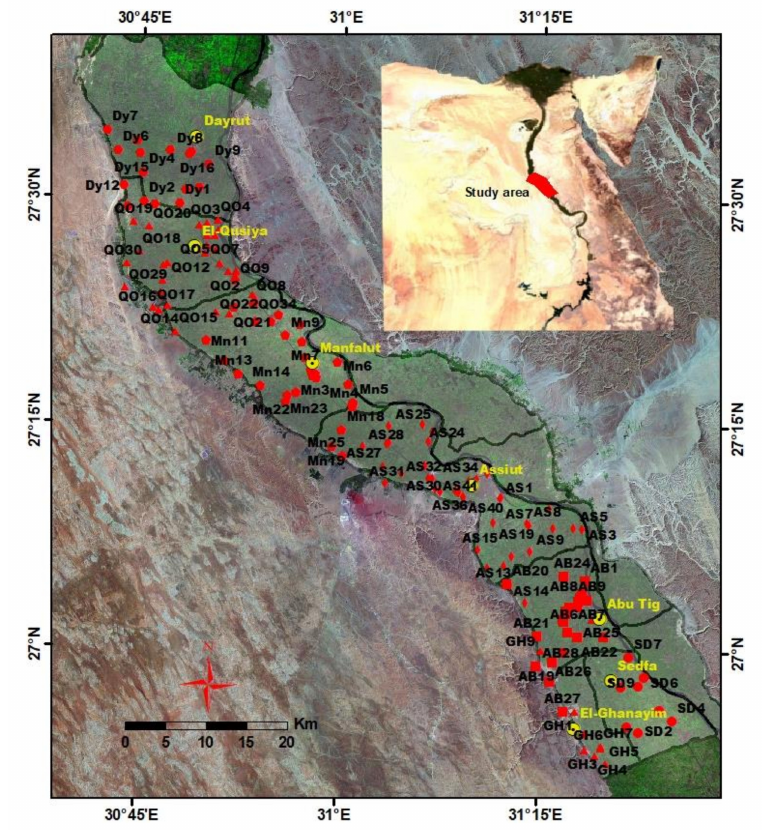
Figure 1. A map showing the location of the study area and the spatial distribution of the drinking water samples within the different districts of Assiut